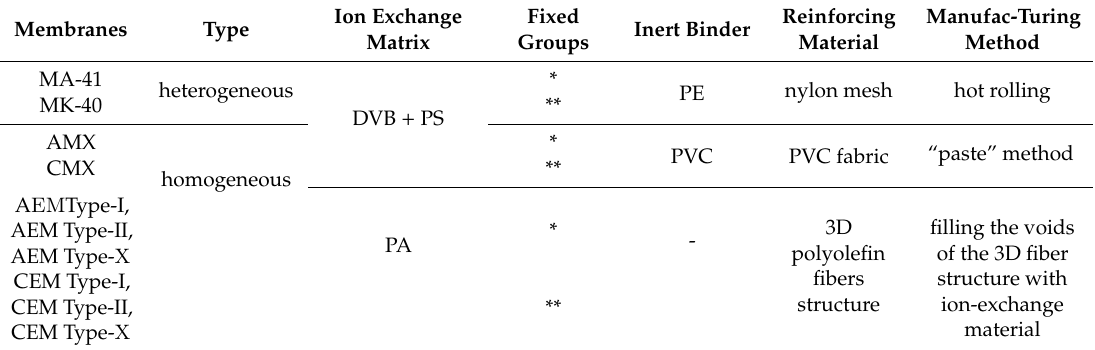
Table 1. Summation of basic materials and membrane manufacturing